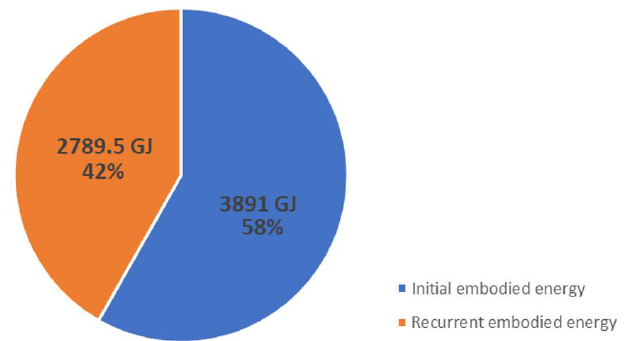
Figure 3. Proportion of the initial and recurrent embodied energy.